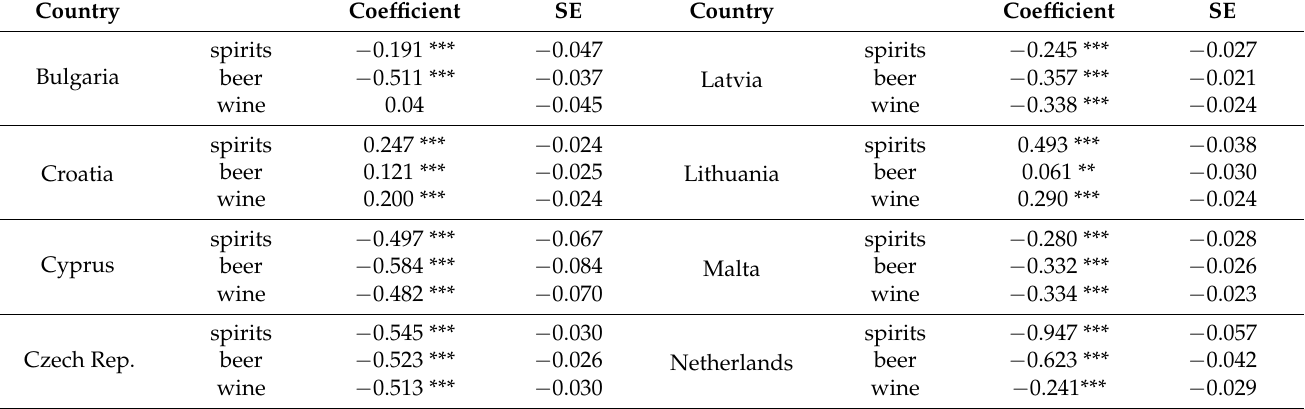
Table A3. Regression coefficients of time trends in beverage proportions with reference category cider/alcopops for